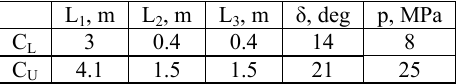
Table 2. Design variables bounds for Stage I